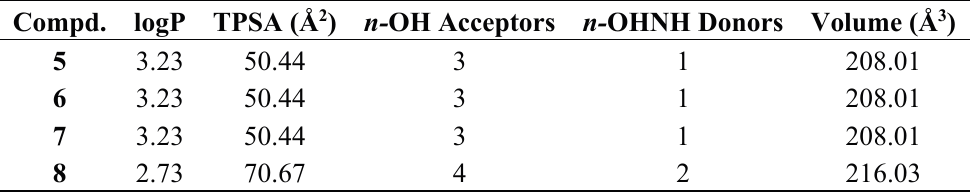
Table 6. Theoretical structural properties of the 3-phenylcoumarins 5 – 8 .